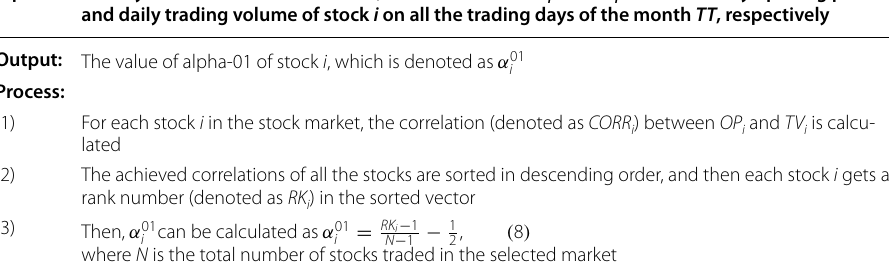
Table 8 The process of calculating the alpha-01 value of each stock set Q in month